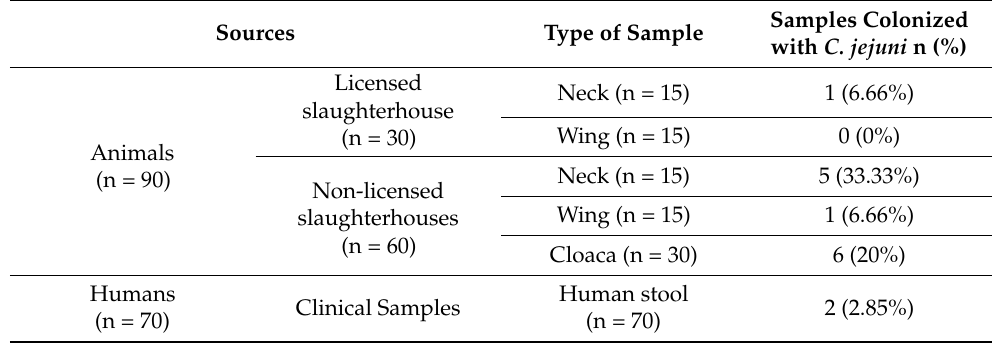
Table 2. The prevalence and the distribution of Campylobacter jejuni among human and chicken samples based on the PCR. Sources Type of Sample